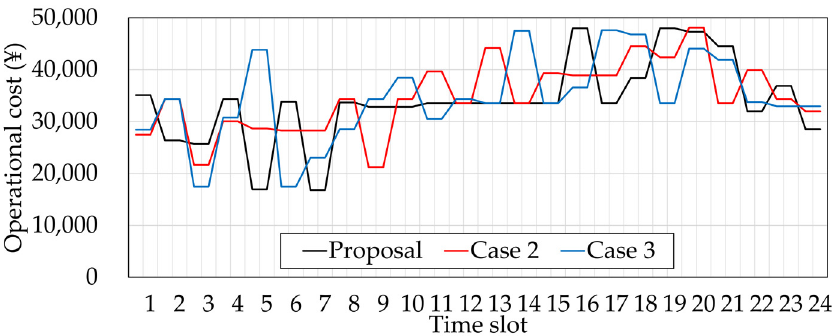
Figure 7. Comparison of operational costs in Cases 1–3. BESS size in each case is 2.62 MWh in Case 1, 2.00 MWh in Case 2, and 3.00 MWh in Case